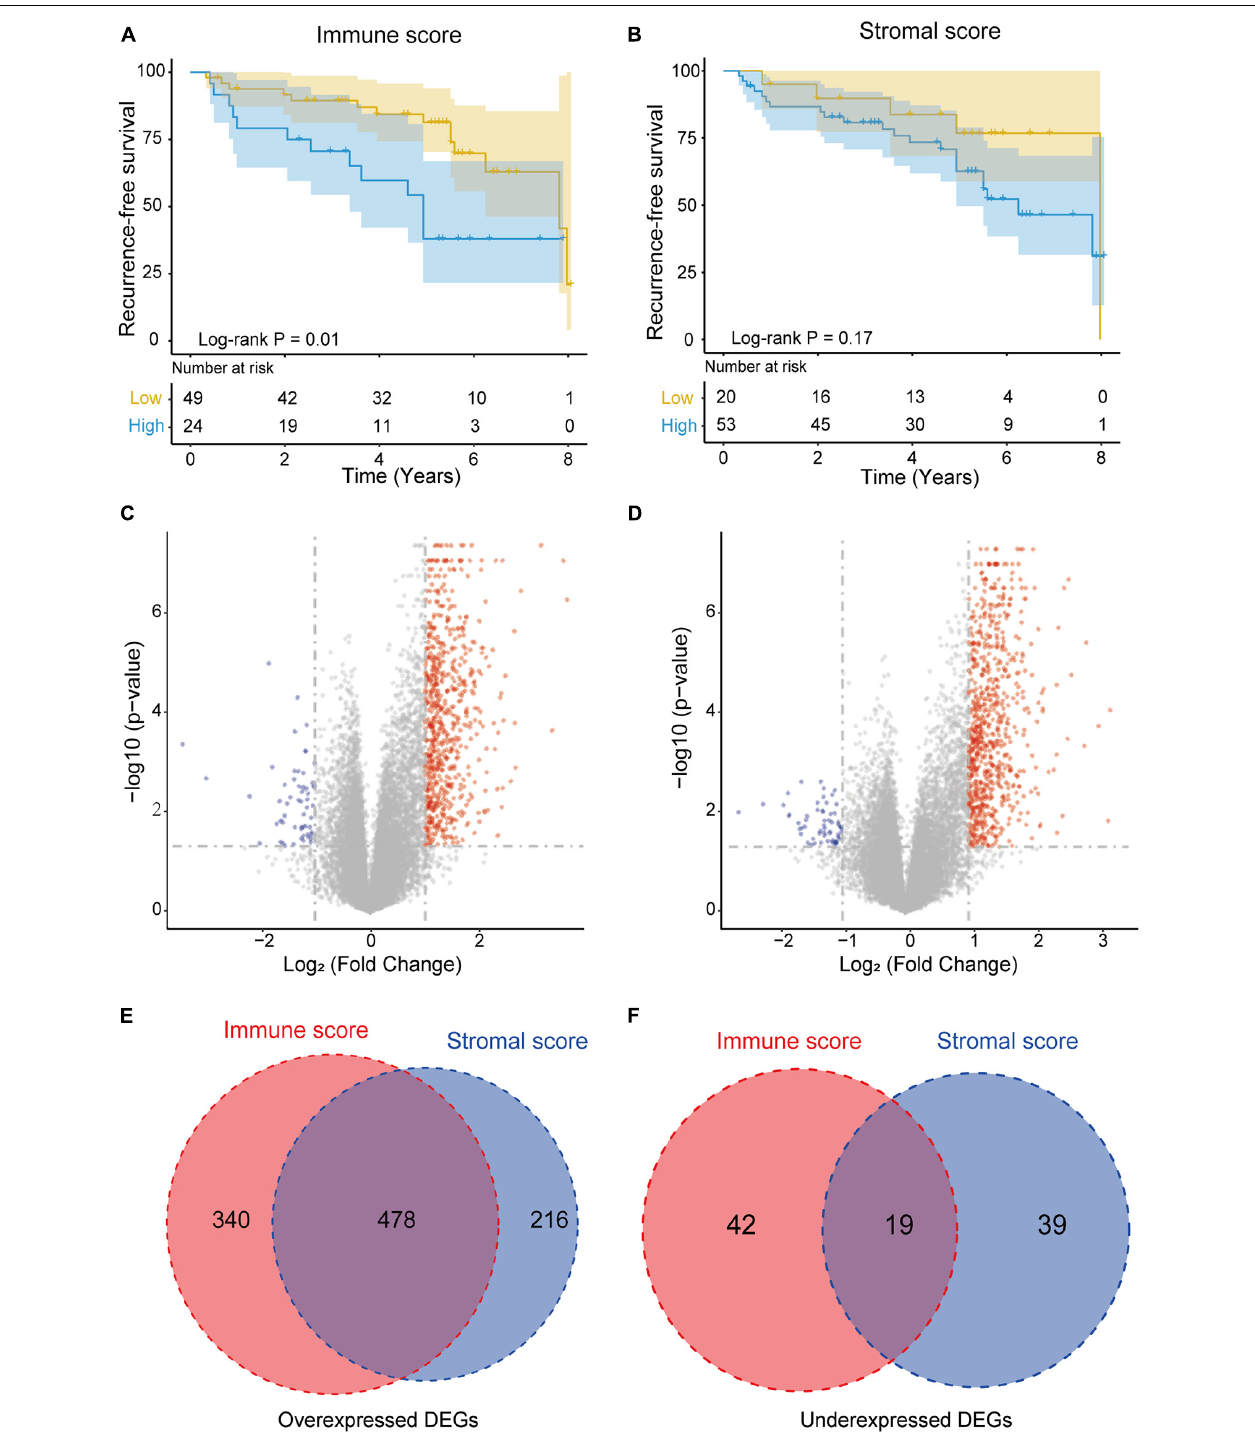
FIGURE 2 | Immune conditions are associated with NFPA recurrence-free survival (RFS) and identification of DEGs based on immune scores and stromal scores. (A) Low immune scores were significantly correlated with an improved RFS ( p = 0.01). (B) Stromal scores were not significantly associated with RFS ( p = 0.17). (C,D) Volcano plot of DEGs from the low vs. high immune score/stromal score groups. Genes with p < 0.05 are shown in red (fold change > 2) and blue (fold change < –2). Black plots represent the remaining genes (those with no significant difference). (E,F) Venn diagrams showing the number of commonly upregulated or downregulated DEGs in the stromal and immune score